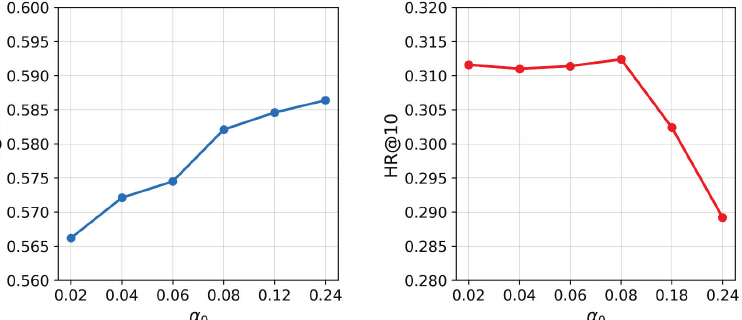
Figure 4. Results of different values of α 0 on the Movielens 10M dataset in terms of HR@10 and CC@10.